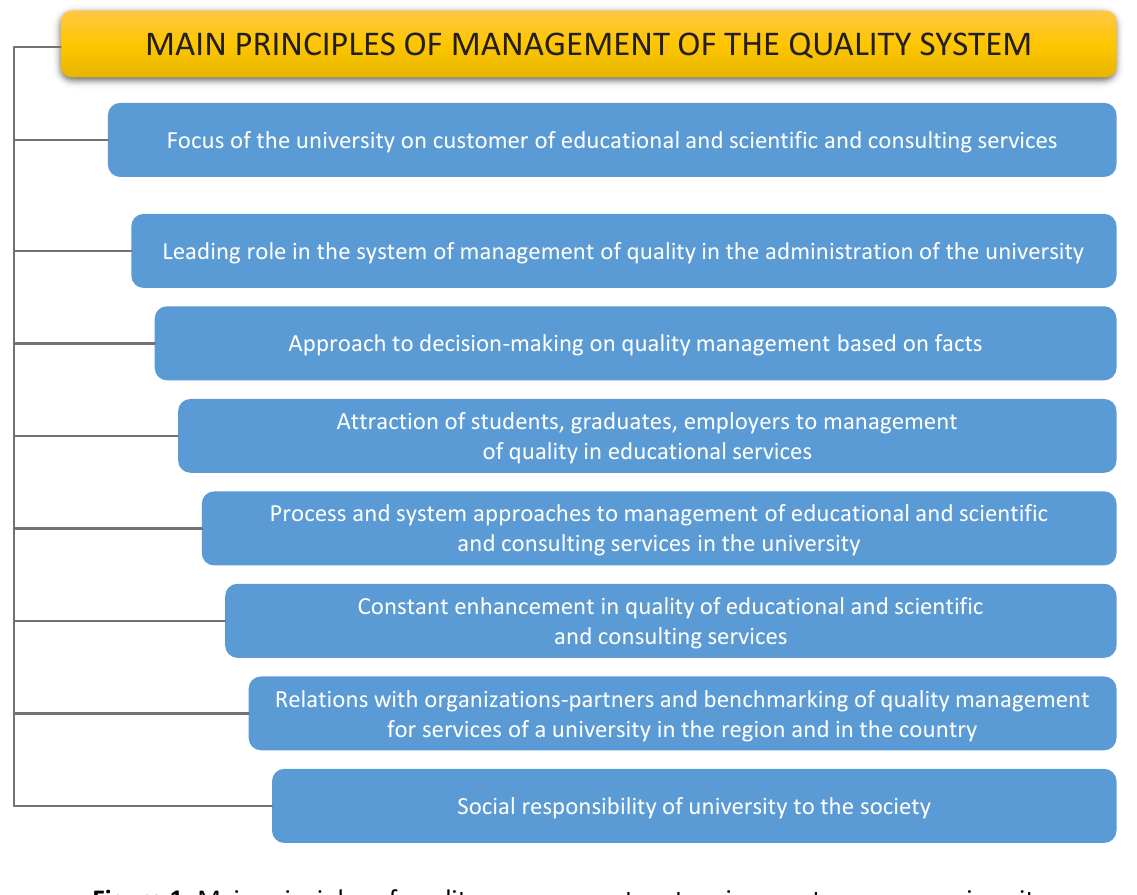
Figure 1. Main principles of quality management system in a contemporary